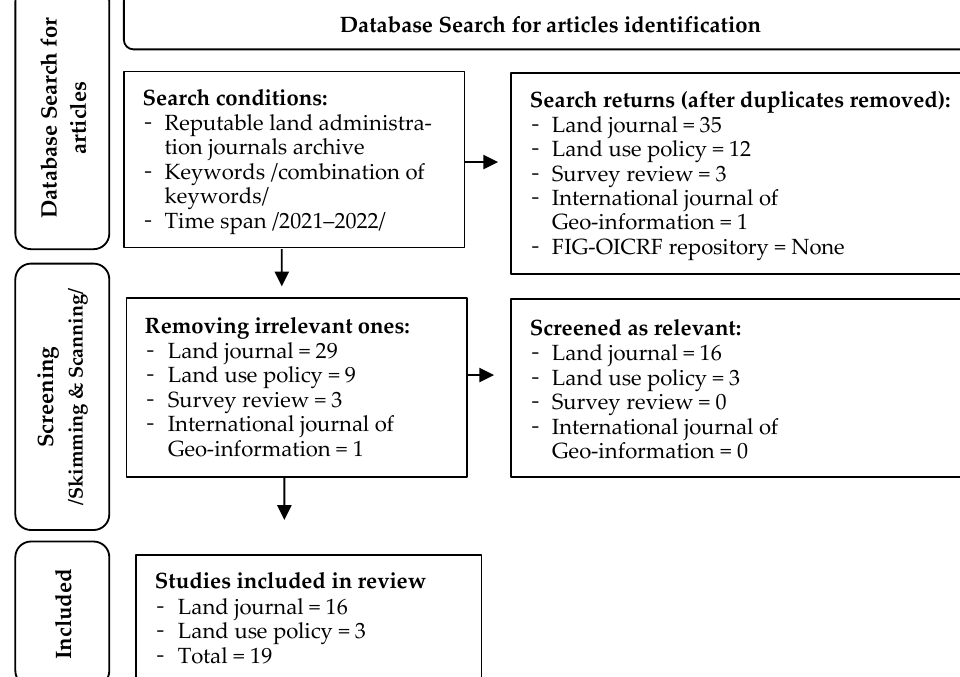
Figure 2 is the flow diagram for the identification of studies from the reputable journals and the OICRF databases (adapted from PRISMA 1 ).